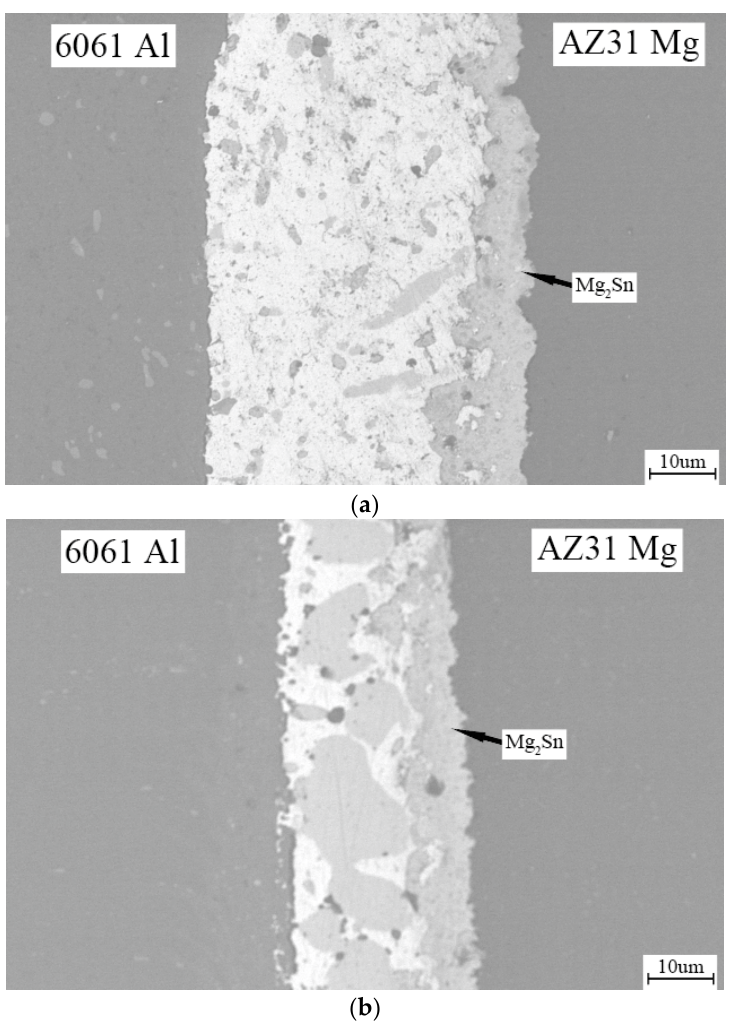
Figure 11. Cross-sectional SEM micrographs of the AZ31 magnesium/6061 aluminum alloy joints bonded with the Sn-20Zn-0.1RE filler metal after aging at 150 °C for ( a ) 50 h; ( b ) 100 h.